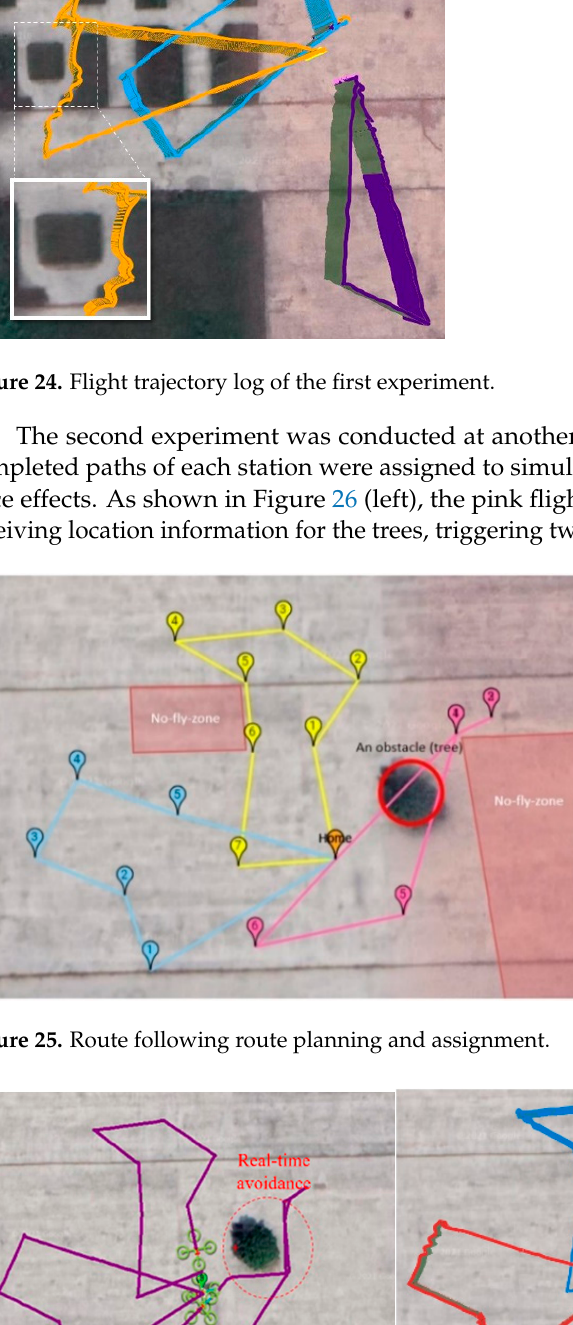
Figure 24. Flight trajectory log of the first experiment.